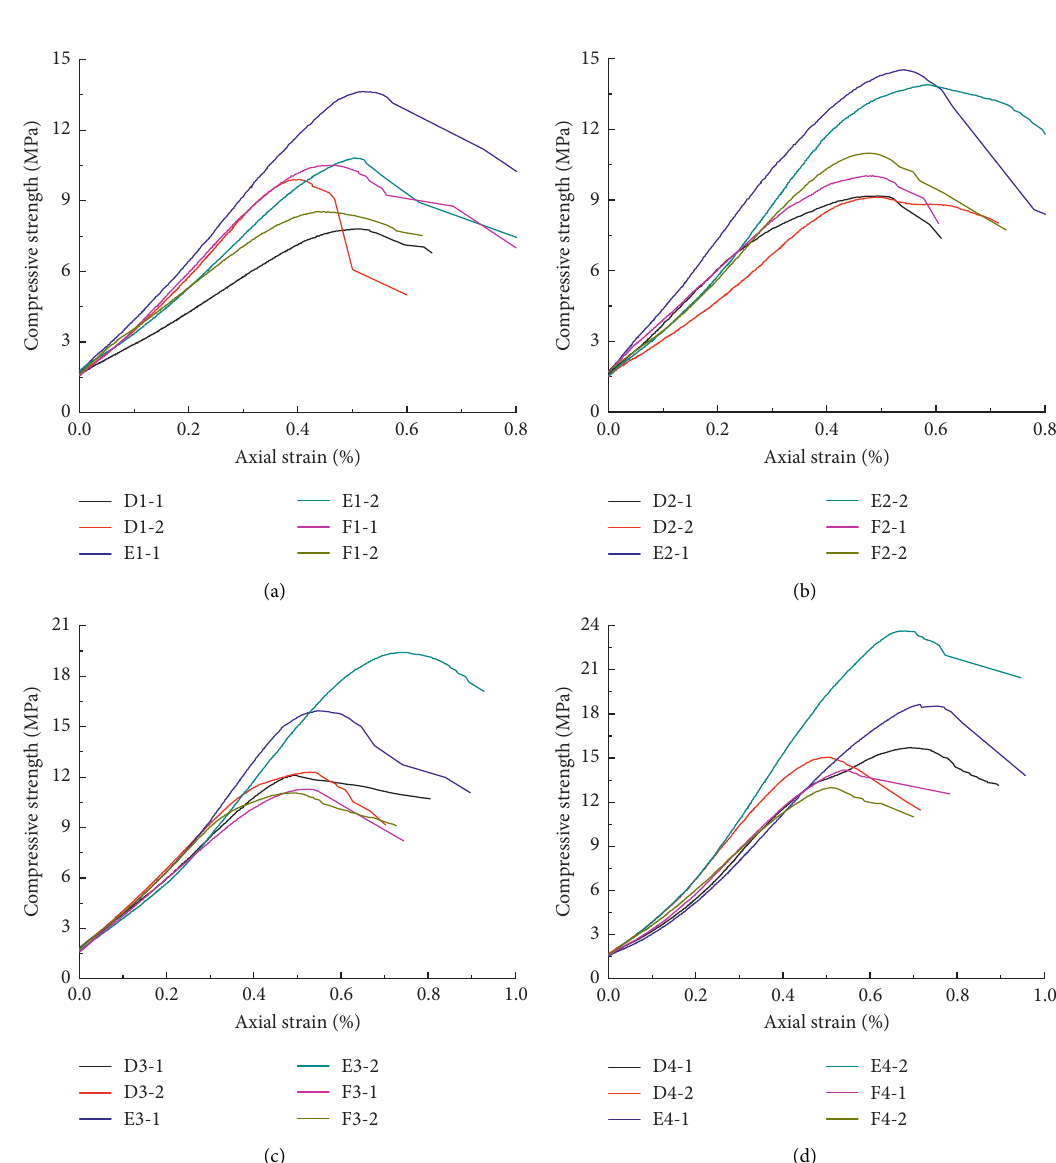
Figure 10: Single-axial compression stress-strain curve of samples. (a) 7-d stress-strain curve. (b) 14-d stress-strain curve. (c) 21-d stress- strain curve. (d) 28-d stress-strain curve.